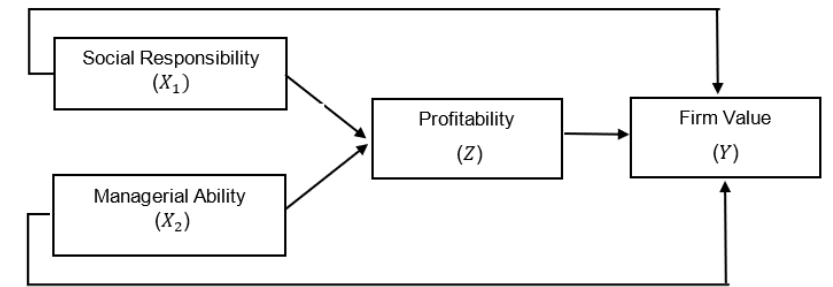
Figure 1: Research Framework and